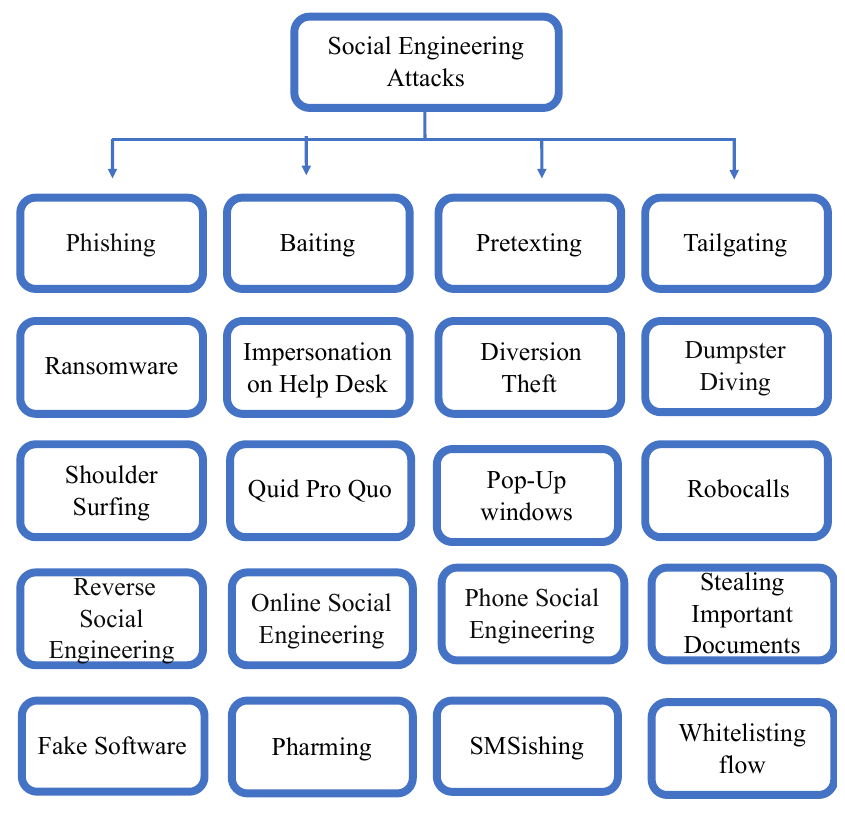
Figure 4. Social engineering attacks.